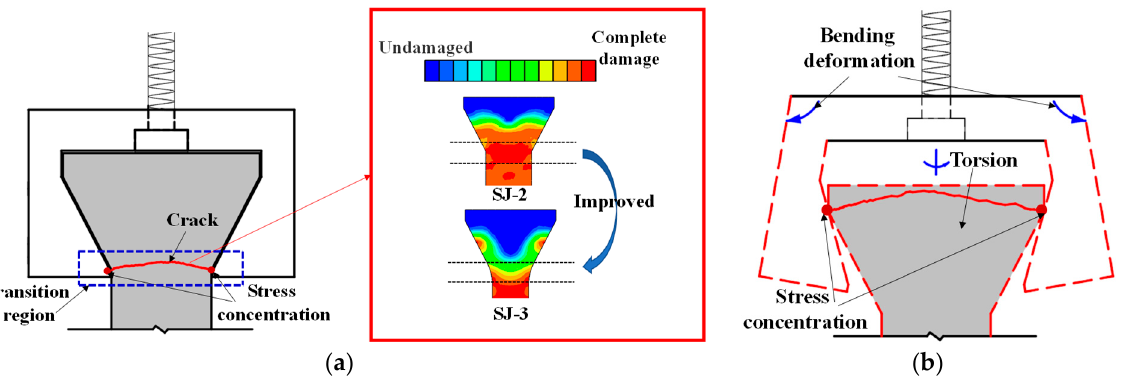
Figure 7. Schematic diagram of strain concentration of specimens, ( a ) transition zone fracture, ( b ) loading end fracture. ( b ) loading end